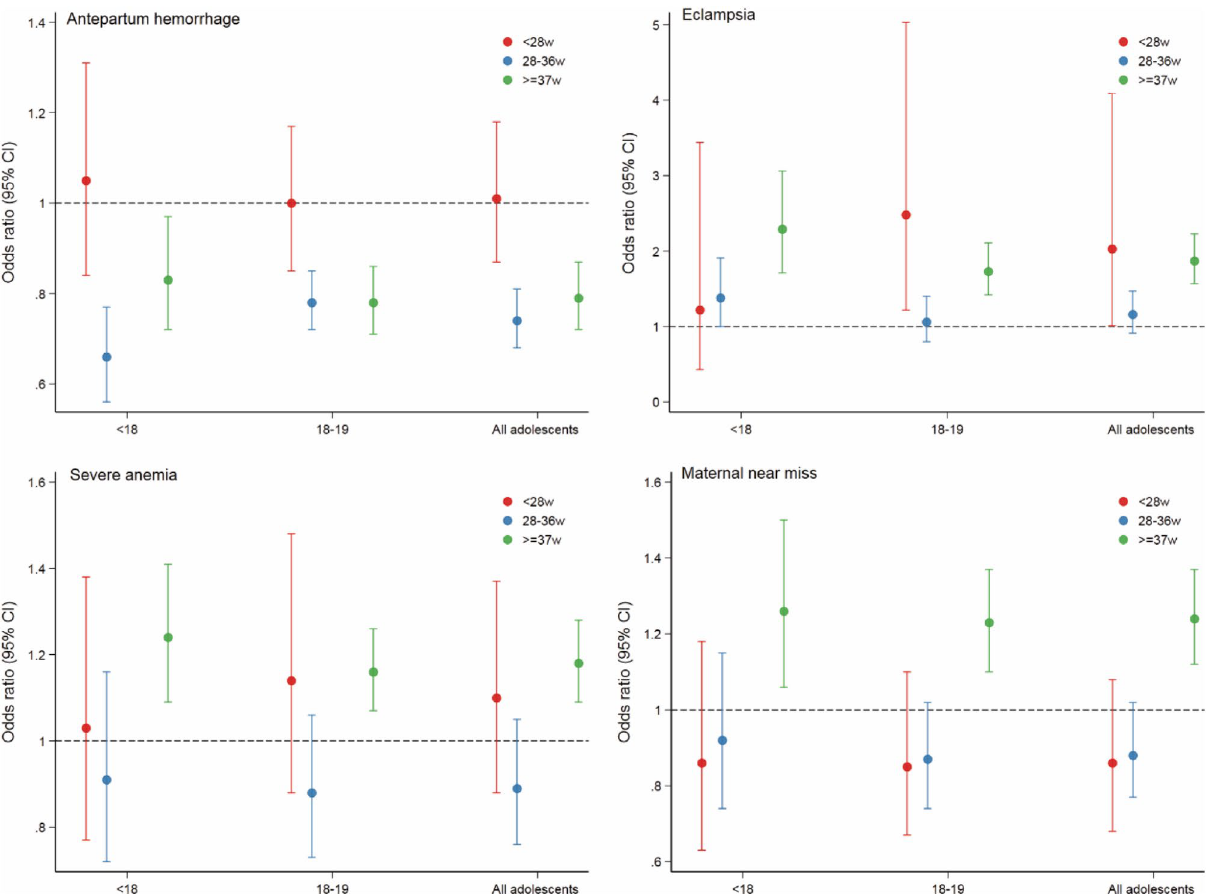
Figure 2. Adjusted odds ratios and 95% confidence intervals of adolescent pregnancies for adverse maternal outcomes stratified by gestational age, women aged 20–24 years served as the reference